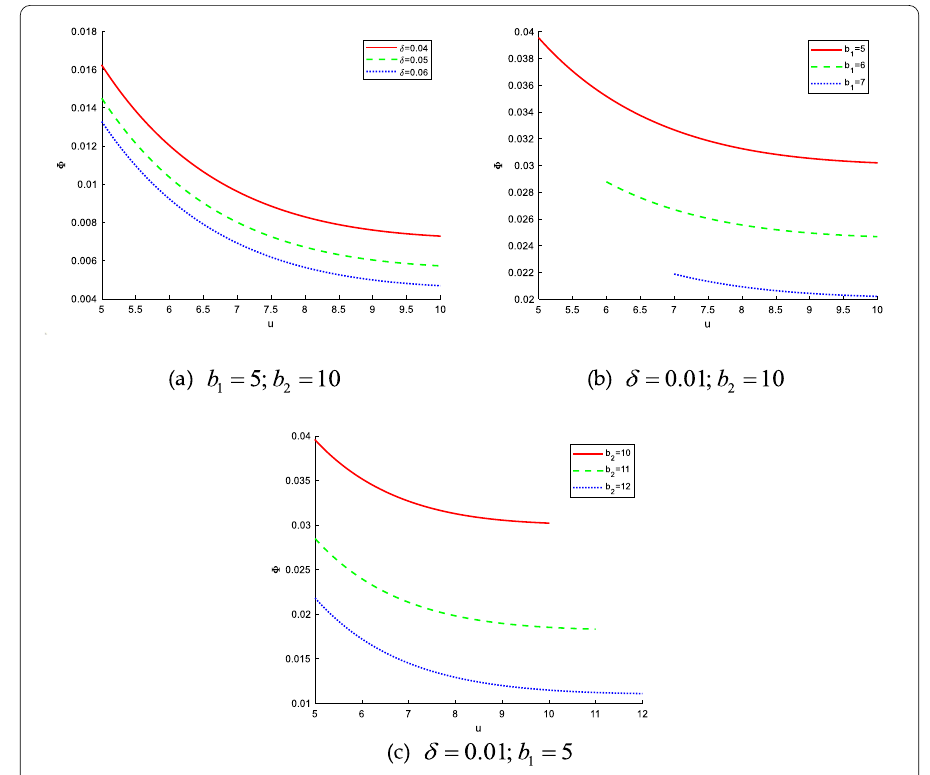
Figure 2 The Laplace transformation of ruin time